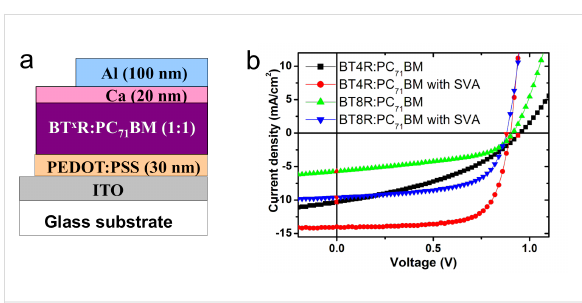
Figure 13: J–V characteristics of BT x R : PC 71 BM ternary BHJ solar cells, a) device architecture, and b) J–V curve for BT x R containing